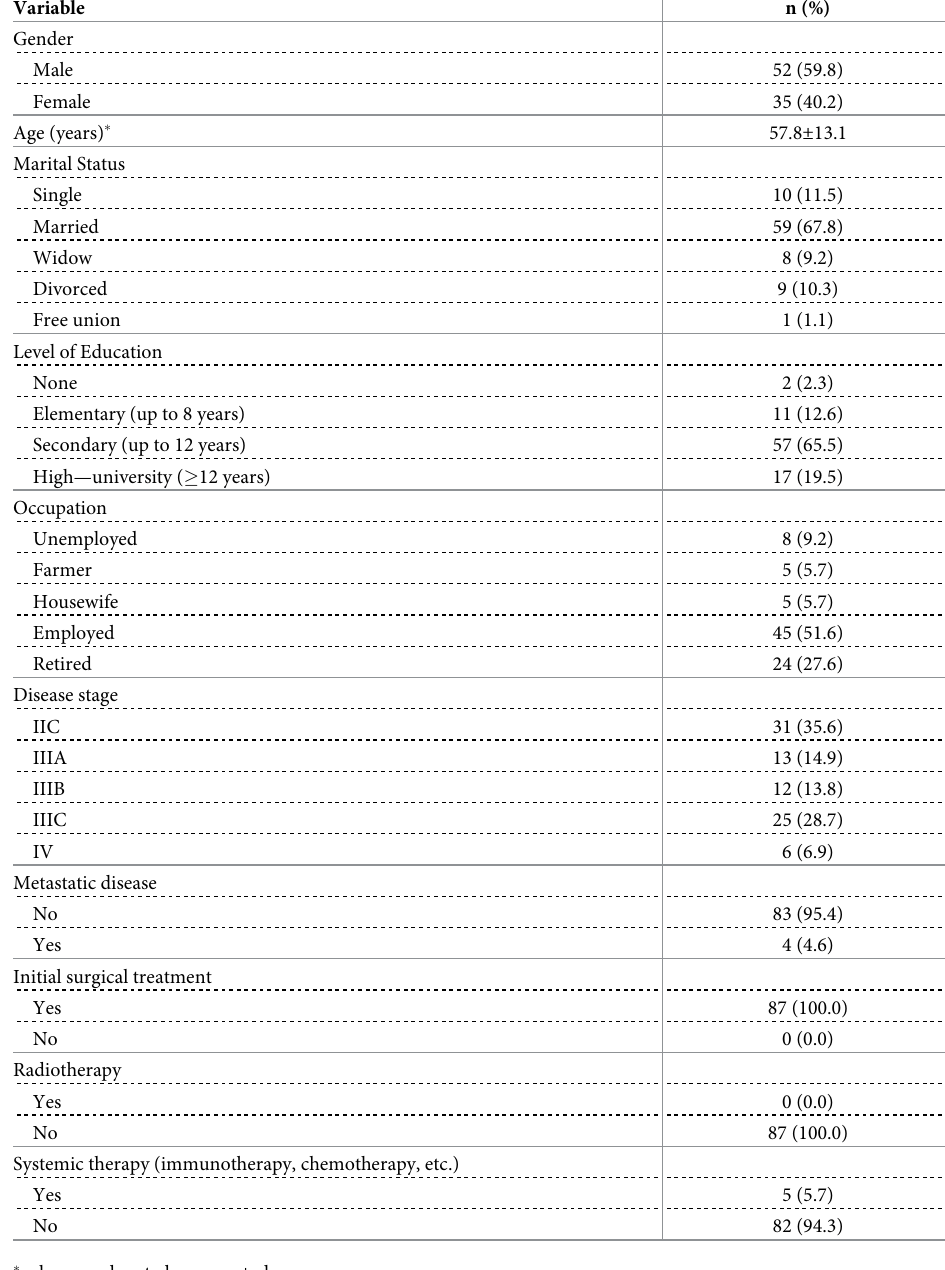
Table 1. Demographic and clinical characteristics of the